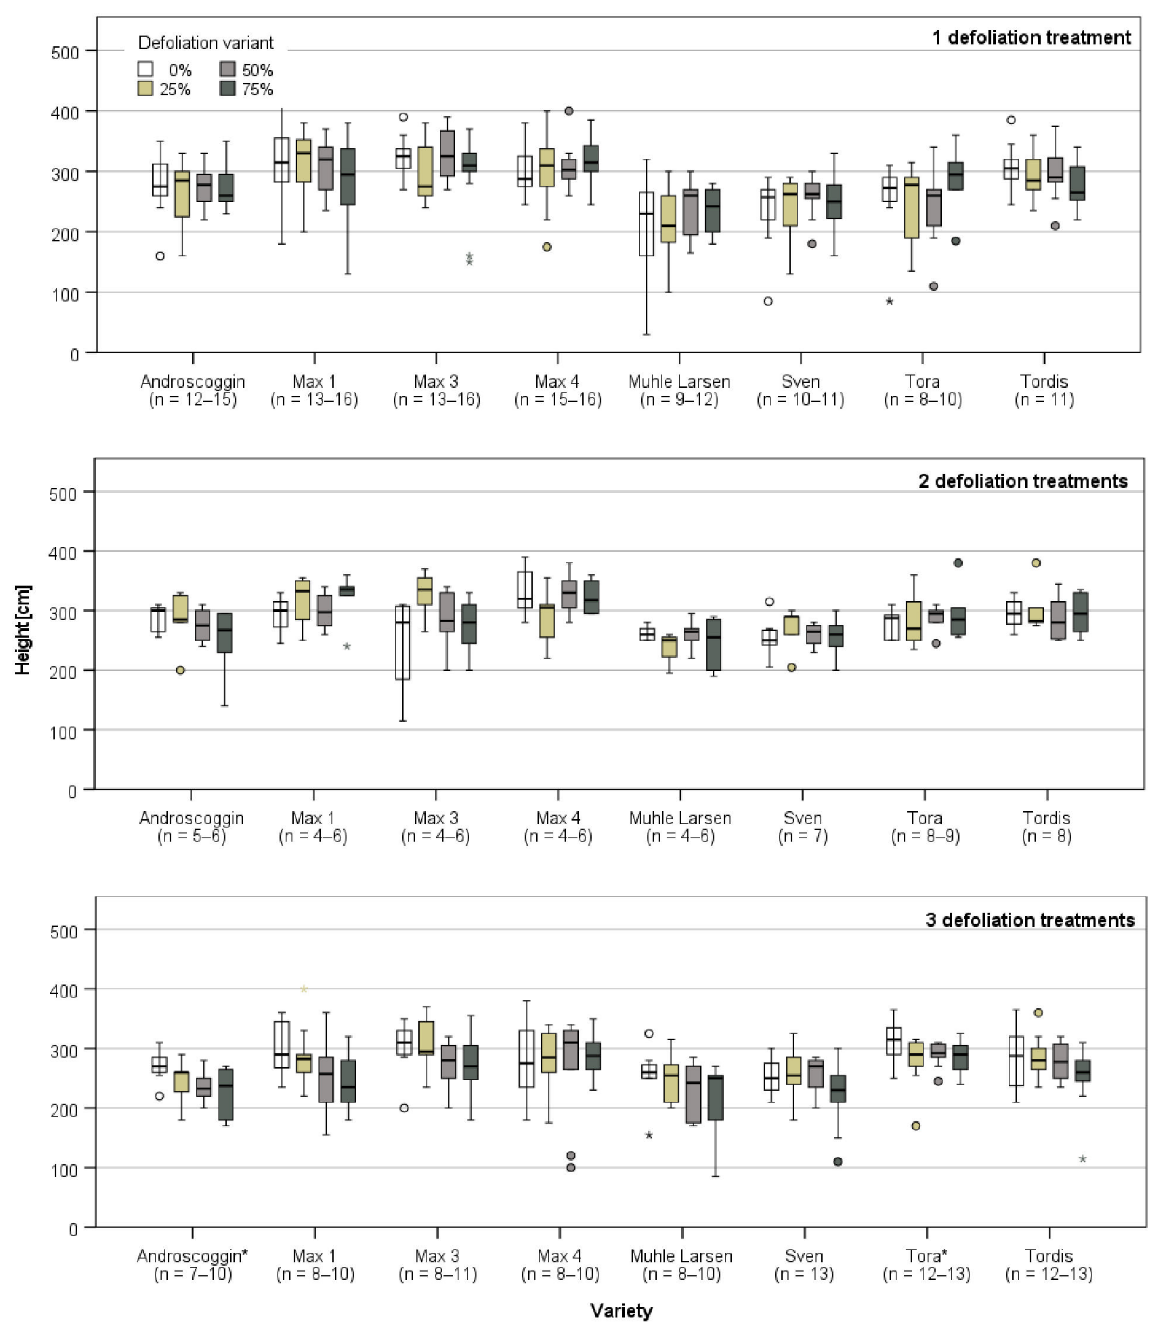
Figure A4. Height of poplar and willow varieties on the study site in Großthiemig in September 2009 after a harvest of the short rotation coppice in March 2009 with regard to the number of defoliation treatments and the defoliation treatment variant in 2007 and 2008 (n = range of number of plants per defoliation variant, * statistically significant difference according to ANOVA).